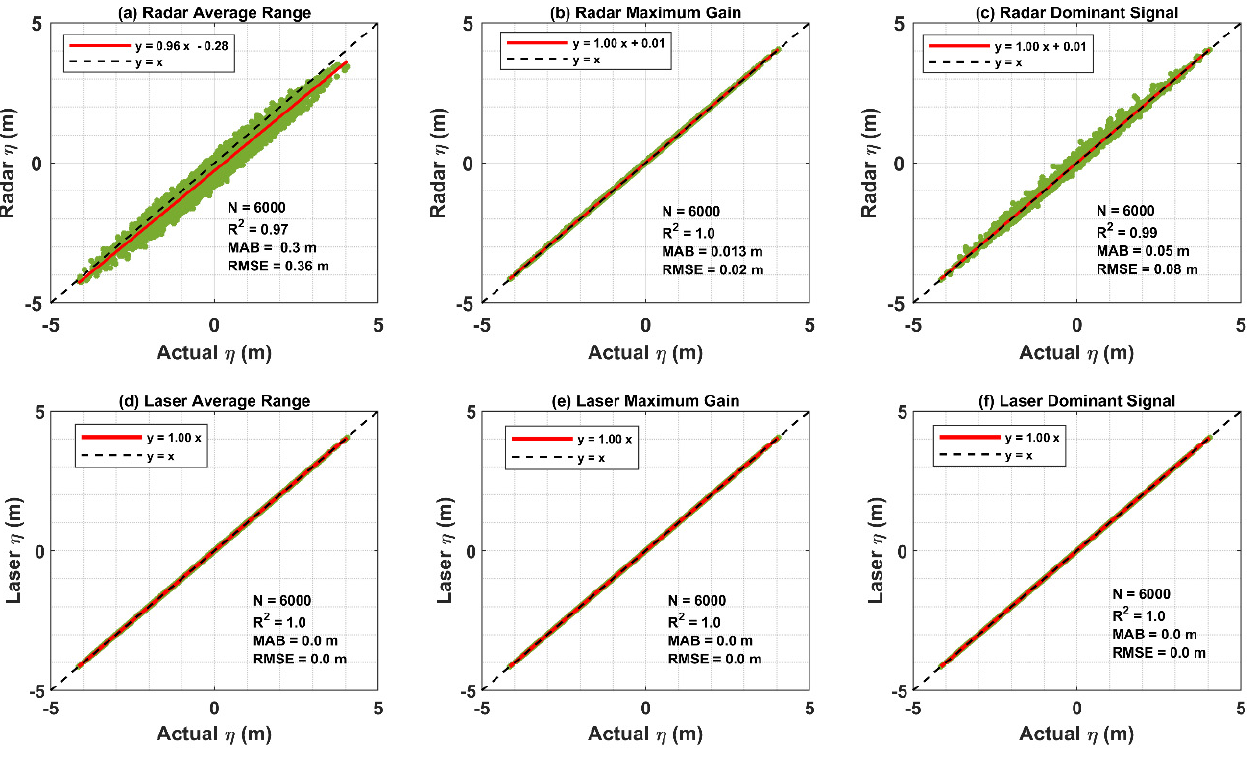
Figure 3. Comparisons of actual surface elevation with average range ( a , d ), maximum gain ( b , e ), and dominant signal ( c , f ) estimated from the Radar and Laser simulations for a sea state with a significant wave height ( 𝐻 𝑚0 ) and peak frequency of 5.2 m and 0.1 Hz, respectively.